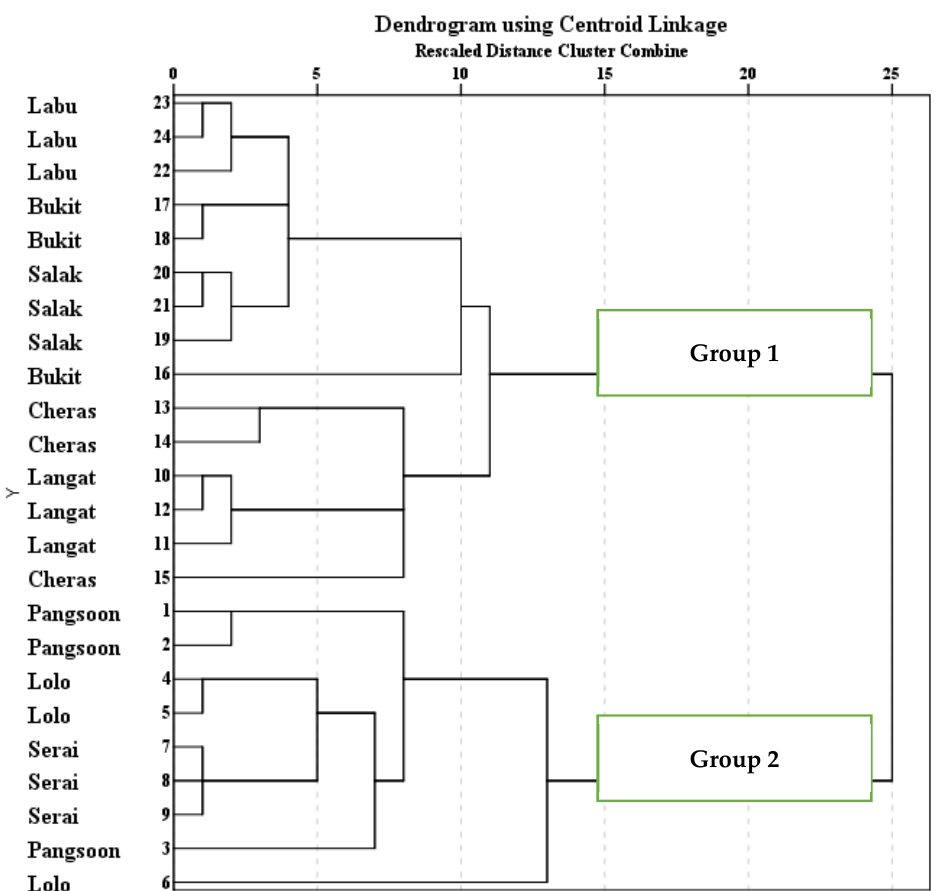
Figure 4. Clustering of river sampling points based on water quality parameters in Langat River, Malaysia.